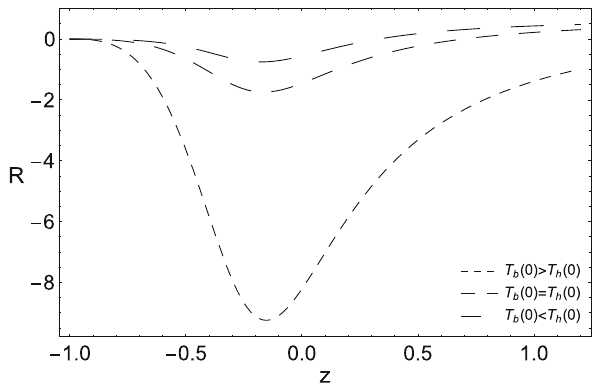
Fig. 6 Deformed GB dark energy model: evolution of parameter R defined in Eq. (24), which allows us to express the nonviolation of the generalized second law through the constraint R ≤ 0. We observe there is a violation of the generalized second law at higher redshifts, independently of the initial conditions T b ( 0 ) = T h ( 0 ) , T b ( 0 ) < T h ( 0 ) and T b ( 0 ) > T h ( 0